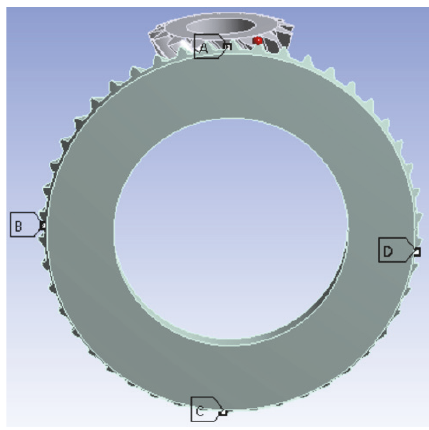
Figure 6: Measuring points position.